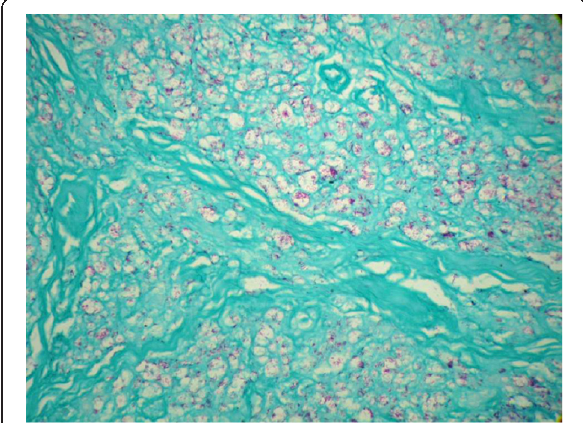
Figure 4 Skin nodule consisting of foamy macrophages with globi of bacilli. Fite-Faraco staining revealed the presence of lepromatous leprosy acid-fast bacilli.